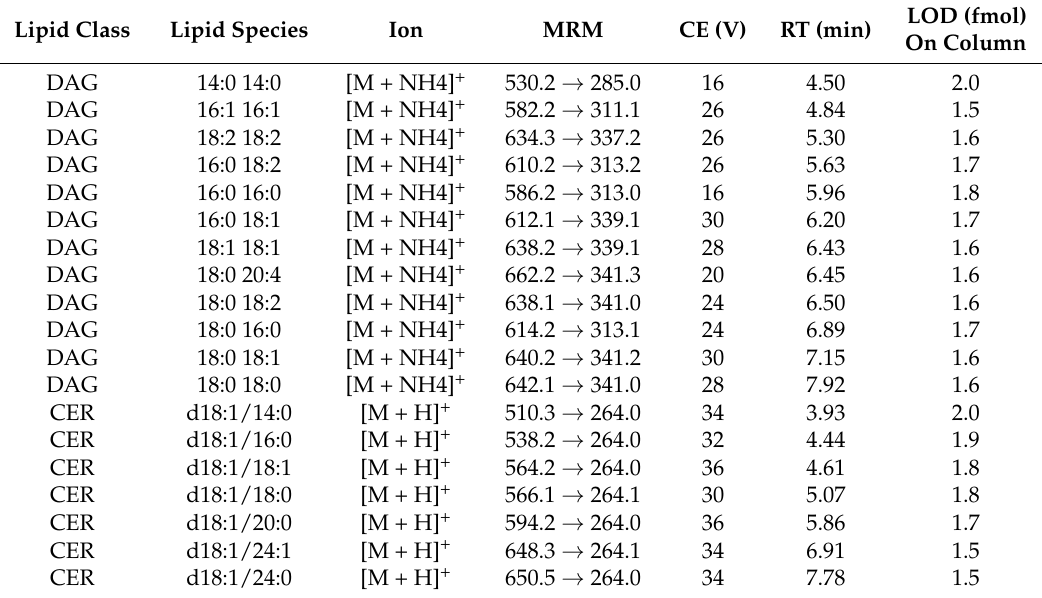
Table 1. Mass spectrometry (MS) parameter and limit of detection (LOD) of lipid